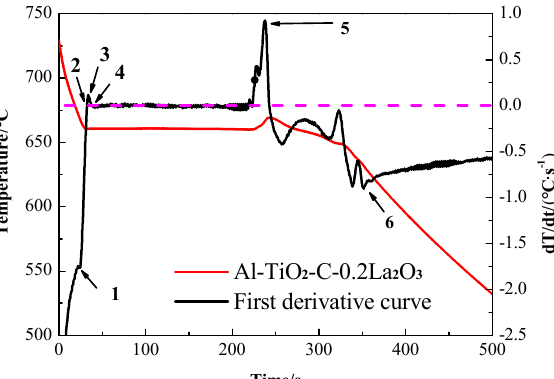
Figure 10. Thermal analysis result of the industrial aluminum with the addition of the Al-TiO 2 -C-0.2La 2 O 3 refiner.